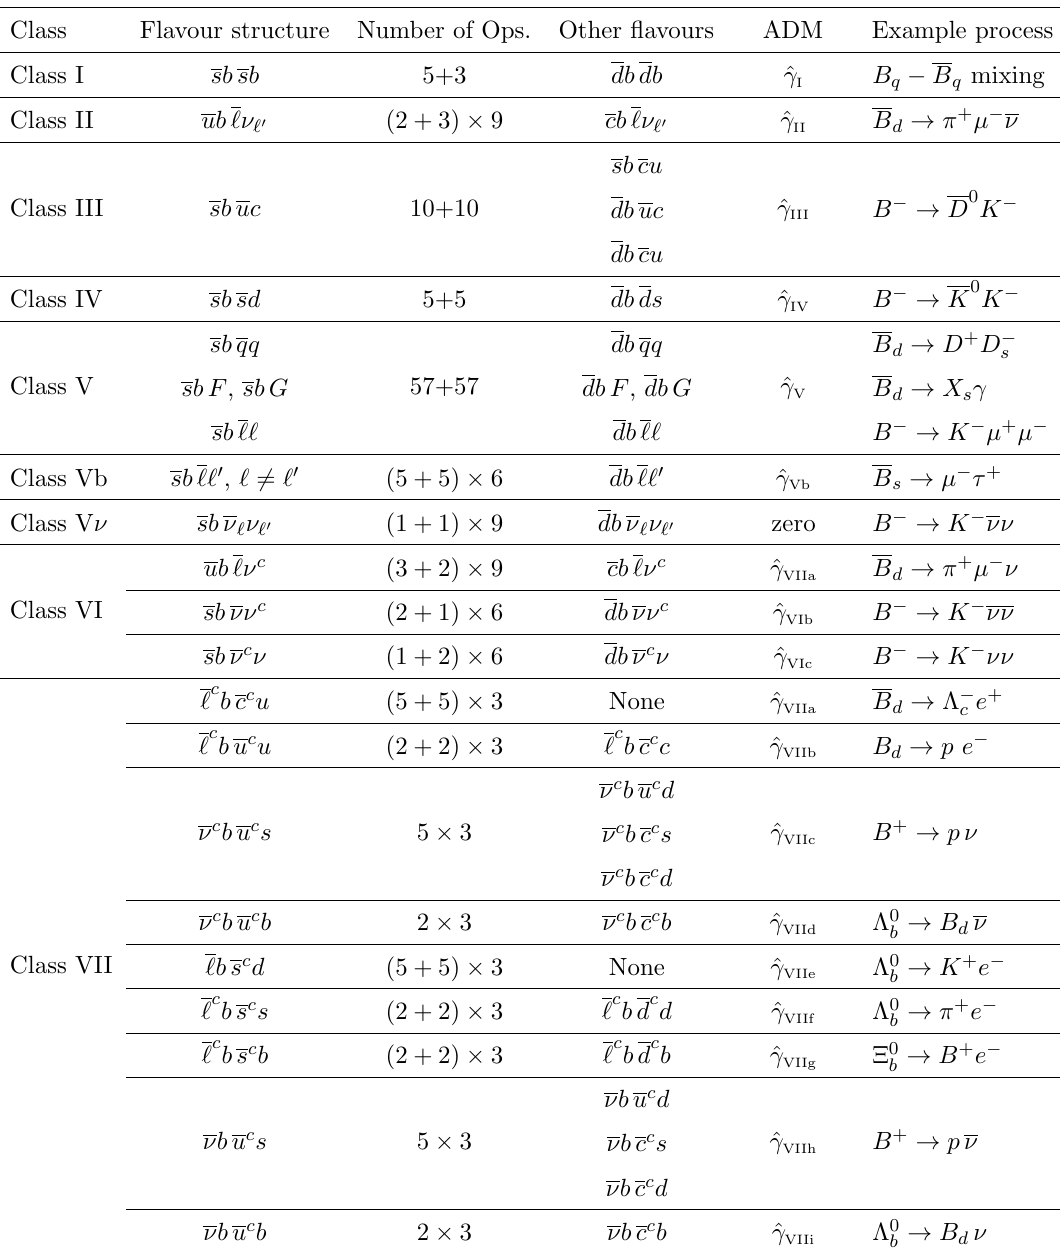
Table 1. Summary list of non-redundant operators. The number of operators in each class is indicated by ( n + n 0 ) (cid:2) n ‘ , where n is the number of di(cid:11)erent operators modulo lepton (cid:13)avours, n 0 is the number of operators with opposite chirality, and n ‘ accounts for the di(cid:11)erent leptonic (cid:13)avours. All the operators with (cid:13)avour structure given in the second column are de(cid:12)ned in section 2, while the ones in the fourth column are obtained by obvious replacements. The last column lists an example of a process to which the corresponding class of operators